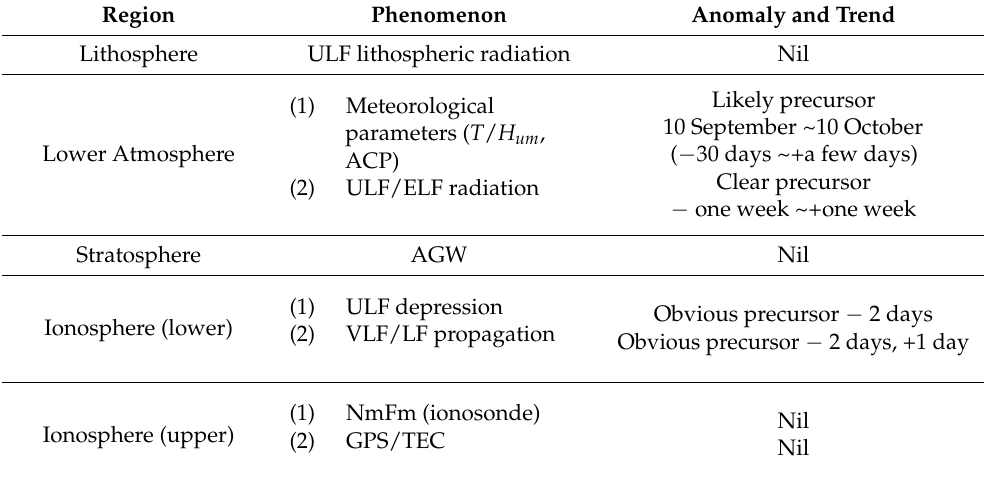
Table 2. Summary of anomalies and